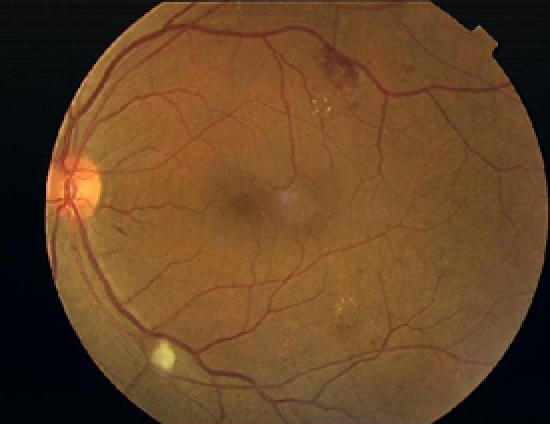
Non-Proliferative Diabetic Retinopathy Showing Macular Edema, a Cotton-Wool Spot below the Optic Disk, and a Few Hemorrhages and Exudates